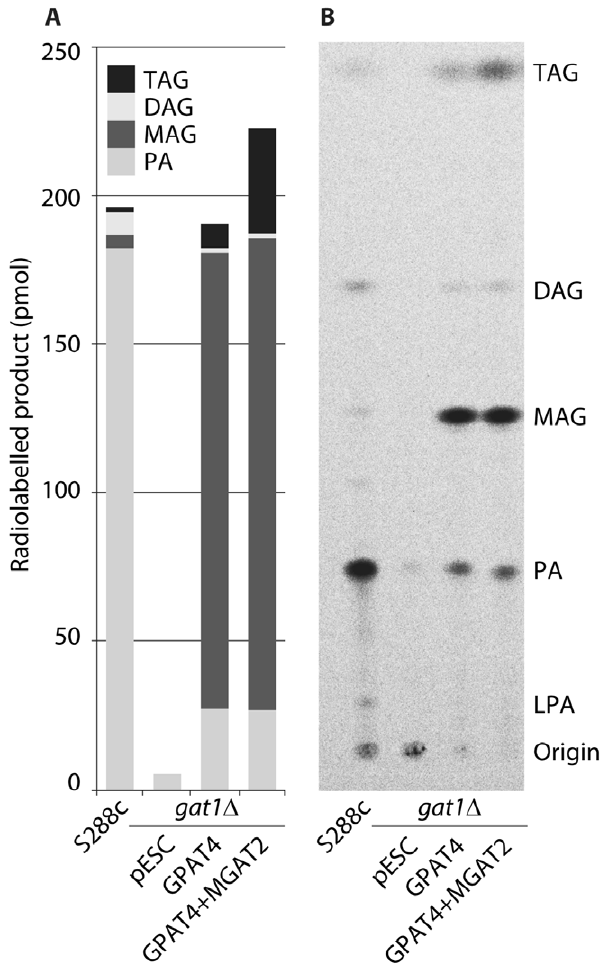
Figure 5. MAG production in vitro by the A. thaliana GPAT4 acyltransferase expressed in S.cerevisiaegat1 D . Yeast homoge- nates were incubated for 30 minutes in the presence of labelled glycerol-3-phosphate and oleoyl-CoA after which neutral and polar lipids were separated in a two-step TLC system as described under Materials and Methods. Homogenates prepared from S. cerevisiae S288c allowed assessment of the contribution of the endogenous Kennedy pathway whilst the M. musculus MGAT2 coexpression tested the alternative MGAT pathway concept. A. Quantification of lipid fraction of GPAT assay (numbers in pmoles). 5% of the MAG (8.5 pmole) produced by the GPAT4 transformant was converted to TAG and this increased to 16% (35.3 pmole) with the addition of the MGAT2. B. TLC plate showing MAG production by GPAT4.